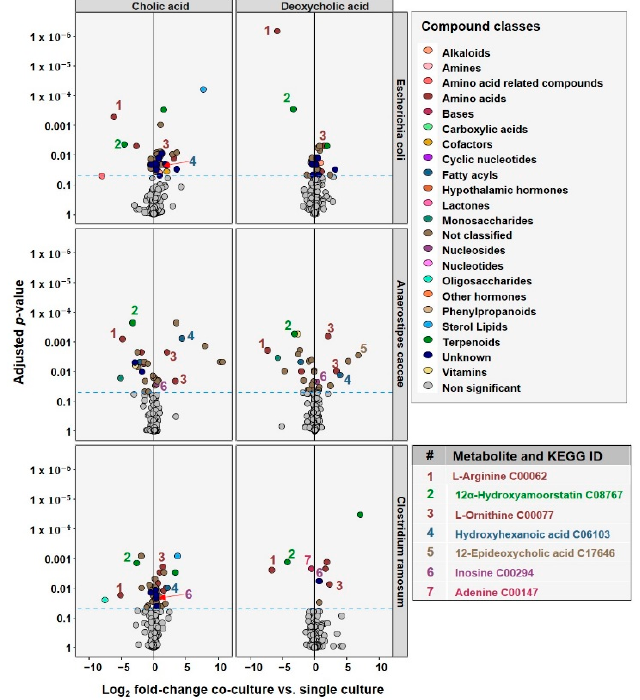
Figure 6. Change in relative abundance of metabolites detected in the medium as calculated by co-culture vs. single culture. Volcano Plot of metabolite Log 2 fold-change in metabolite abundances plotted against Benjamini–Hochberg adjusted p -values. Measurements are from the medium super- natants of cultures grown in the bile acid stress assays. Significant metabolites are color coded by compound class. Dashed blue line indicates p = 0.05.